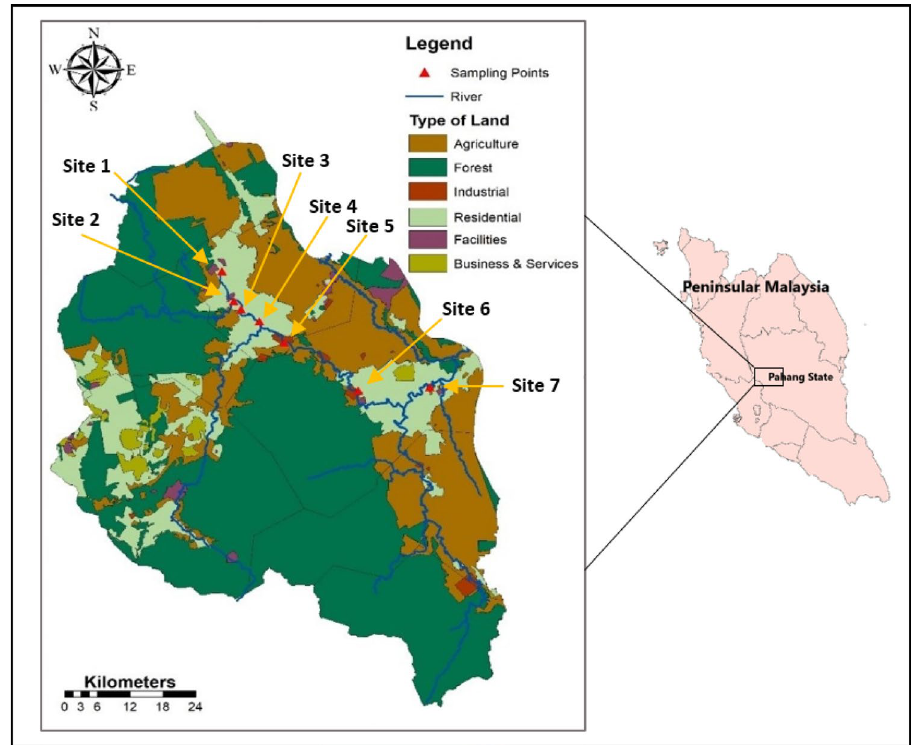
Figure 1. Location map and sampling sites of study area in Bentong, Pahang State,